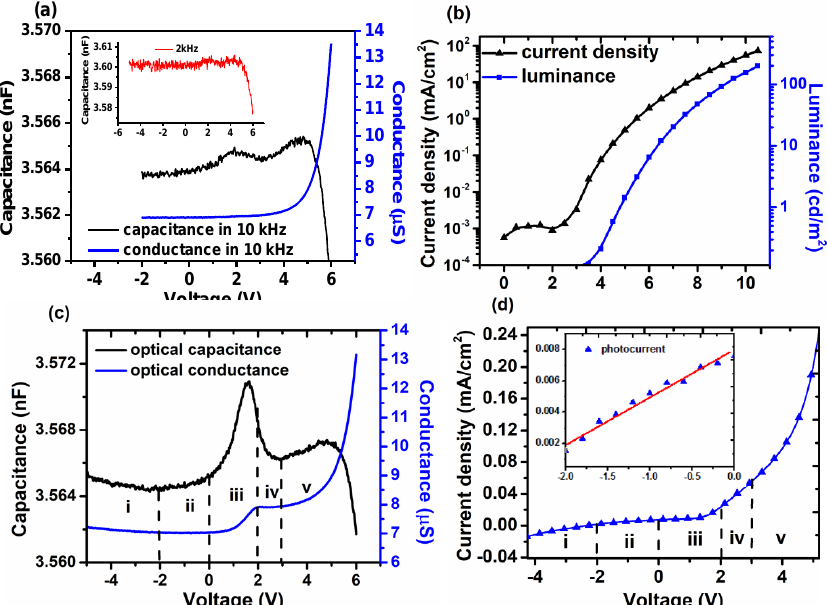
Figure 2. ( a ) The C-V and G-V characteristics of control device under dark, inset is the C-V characteristic in 2 kHz ( b ) The J-V-L characteristics of the control device. ( c ) The C-V and G-V characteristics of control device under illumination ( d ) The photocurrent of control device under illumination, inset is the photocurrent in region ii.